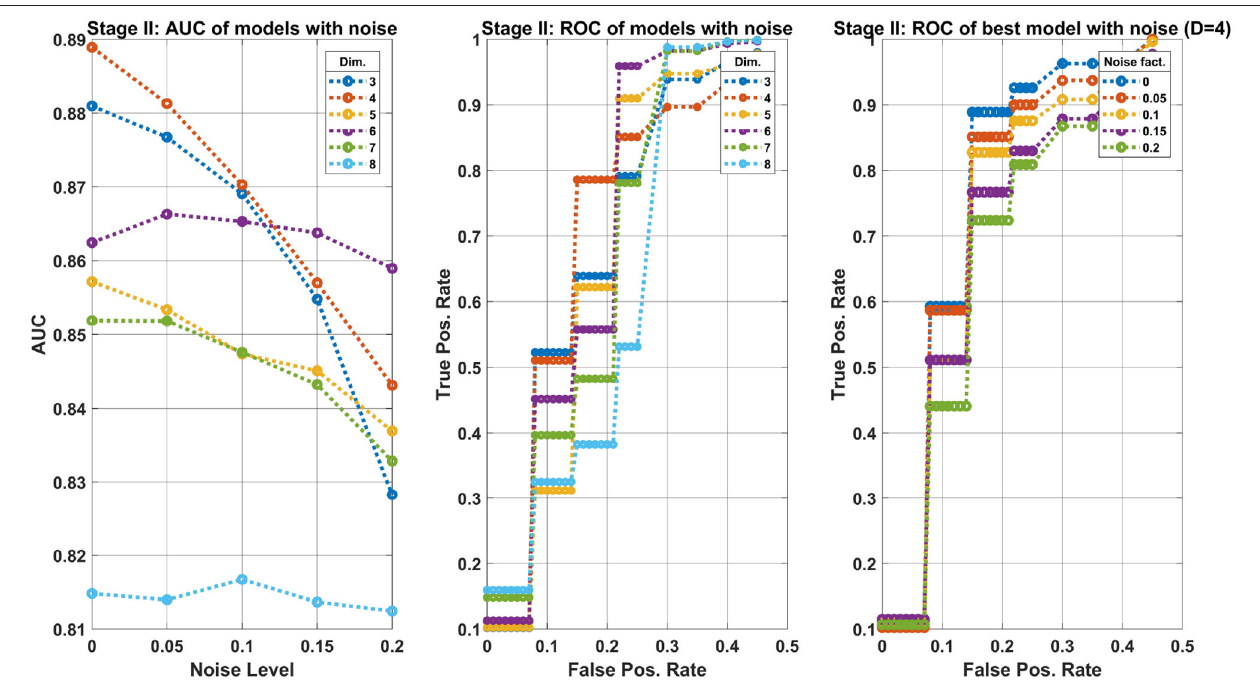
FIGURE 8 | Machine learning results of the second classification stage: separating precancer from cancer classes of the Transgenic group. The structure of the figure are as Figure 7 . The main difference between the two stages is the reduced performance observed here. In particular, the best model achieves a TPR ≈ 0.8 at an operating point where FPR ≈ 0.2